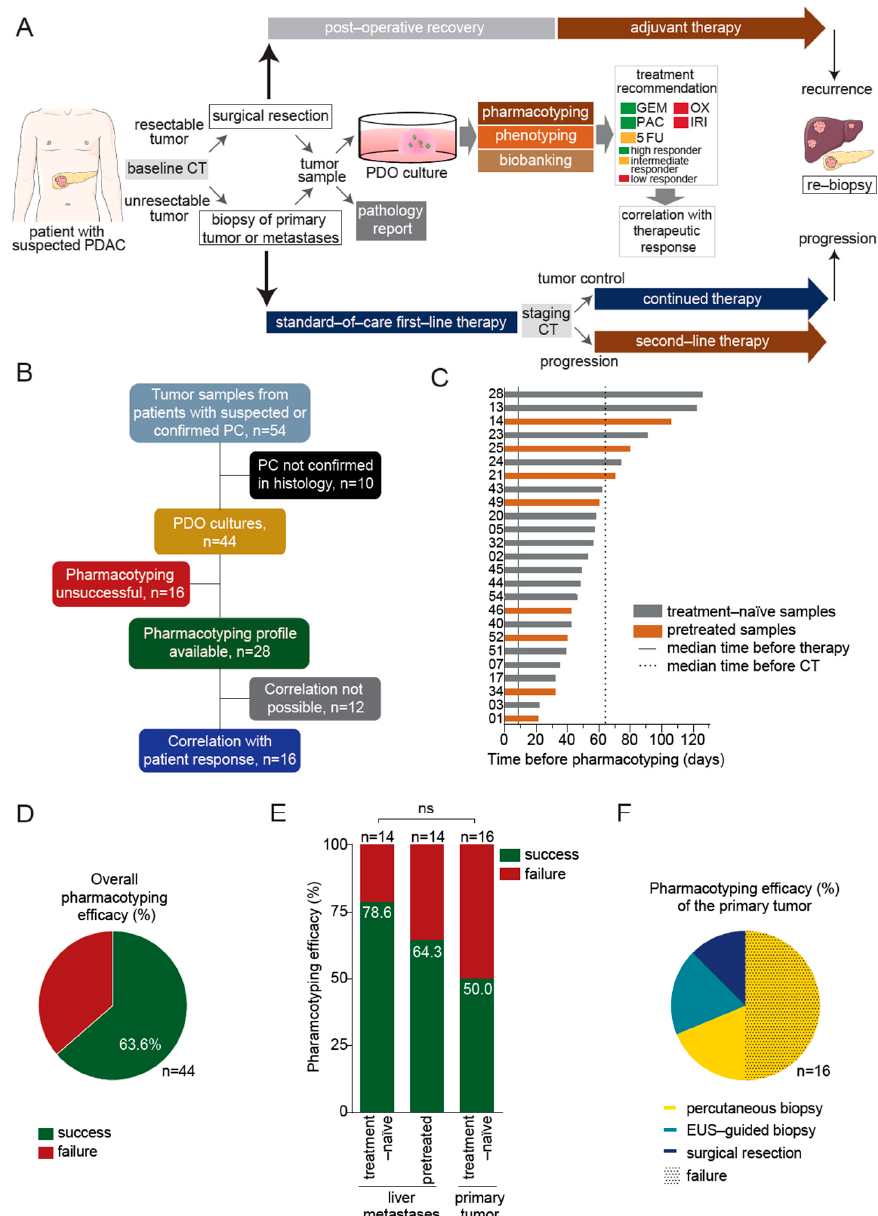
Figure 1. Feasibility of organoid-based precision medicine in clinical routine. ( A ), Schematic representation of the work-flow. Patient-derived organoids (PDOs) were isolated from surgical specimens or biopsy samples of the primary tumor or liver metastases in pancreatic cancer (PC) patients. PDOs were submitted to pharmacotyping, phenotyping, and biobanking. The in vitro prediction was compared to the therapeutic response in the patient. ( B ), Schematic representation of the study. ( C ), Graphic representation showing the time required before PDO pharmacotyping. ( D ), Representation of the overall PDO pharmacotyping efficacy. ( E ), Representation of the pharmacotyping efficacy in PDOs isolated from liver metastases of either treatment-naïve or pretreated patients, or from the primary tumor. ( F ), Pie chart showing the pharmacotyping efficacy of the primary tumor according to the sampling method (percutaneous biopsy, n = 11; endoscopic ultrasound (EUS)-guided biopsy, n = 3; surgical resection, n = 2); dotted pattern depicts pharmacotyping failure. 5-FU, 5-fluorouracil; GEM, gemcitabine; IRI, irinotecan; OX, oxaliplatin; PAC, paclitaxel; CT, computed tomography; ns, not significant.